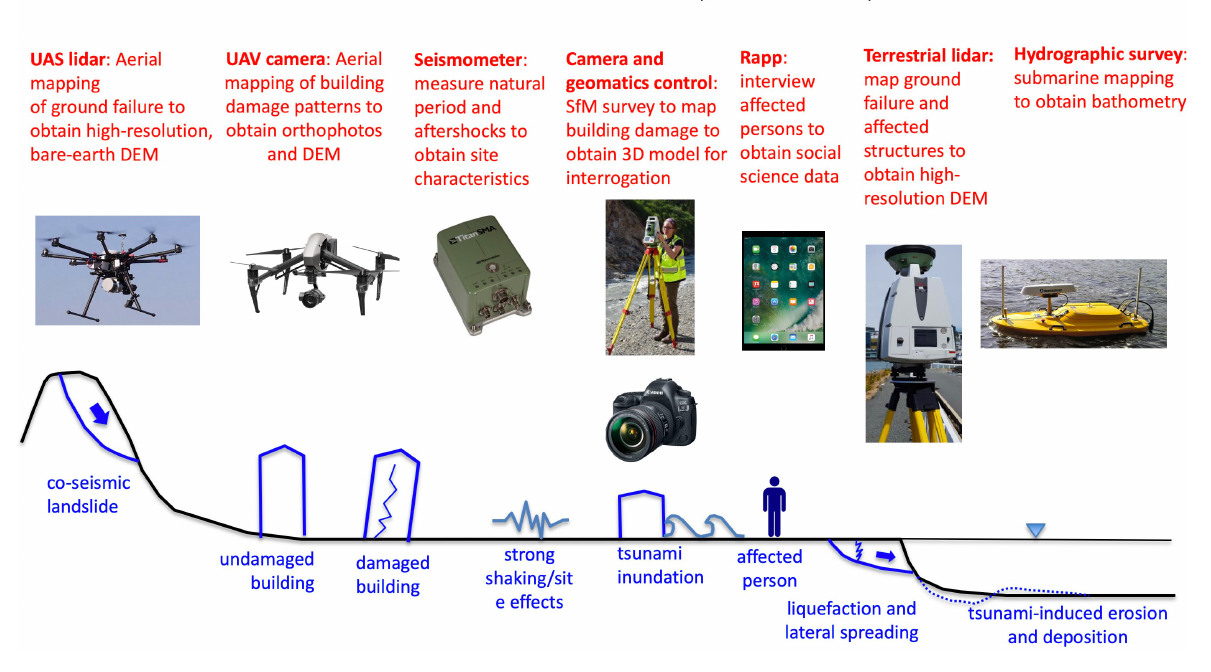
Frontiers in Built Environment |